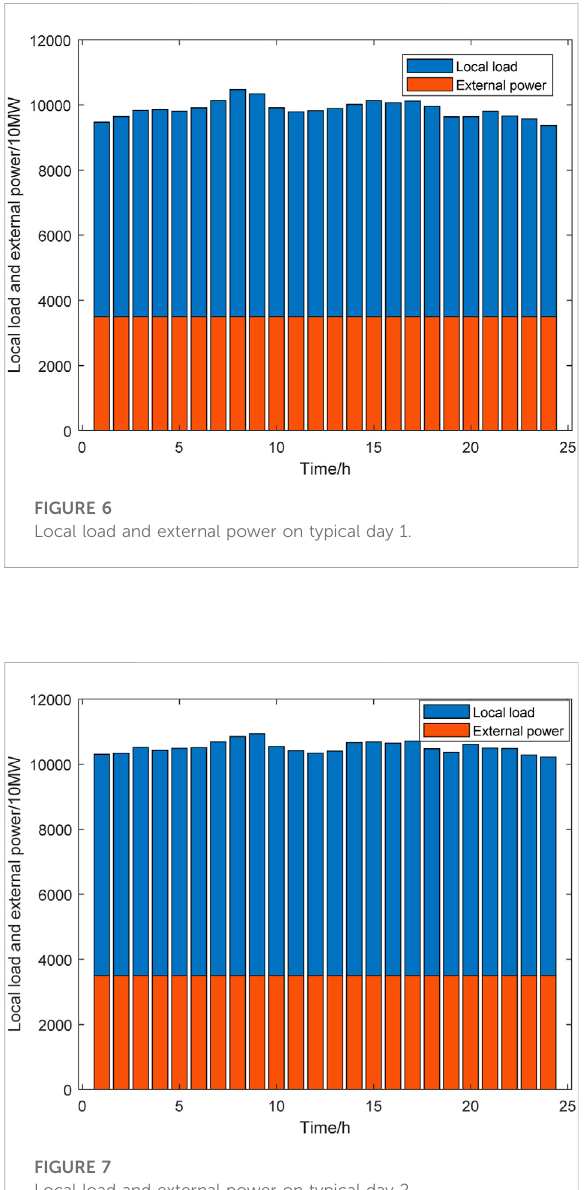
FIGURE 7 Local load and external power on typical day